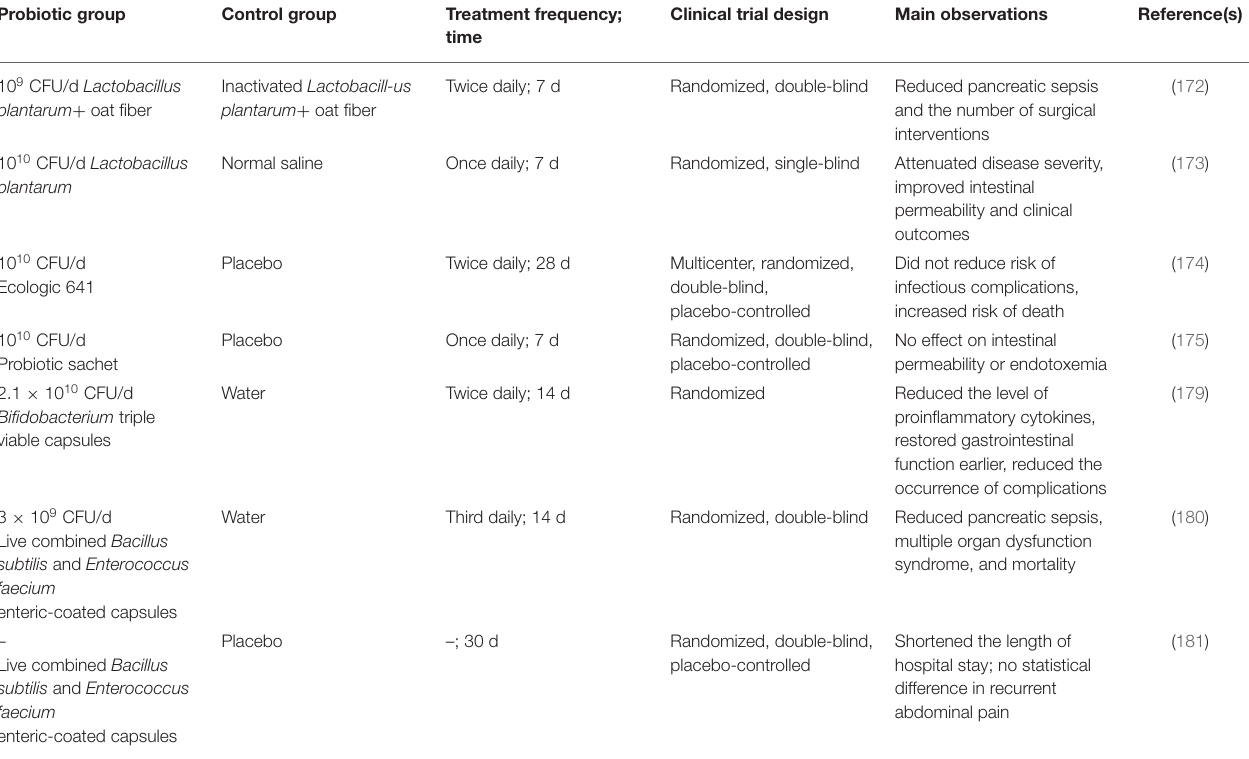
TABLE 2 | Summary of clinical trials investigating the efficacy of probiotic application in pancreatitis. Probiotic